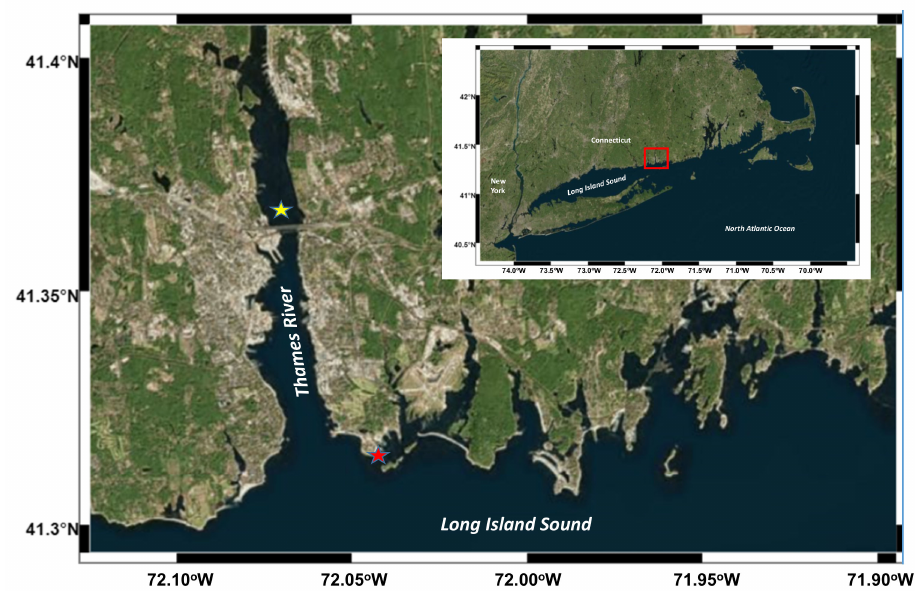
Figure 1. Study area. The red star denotes the coastal site, while the yellow star denotes the estuarine